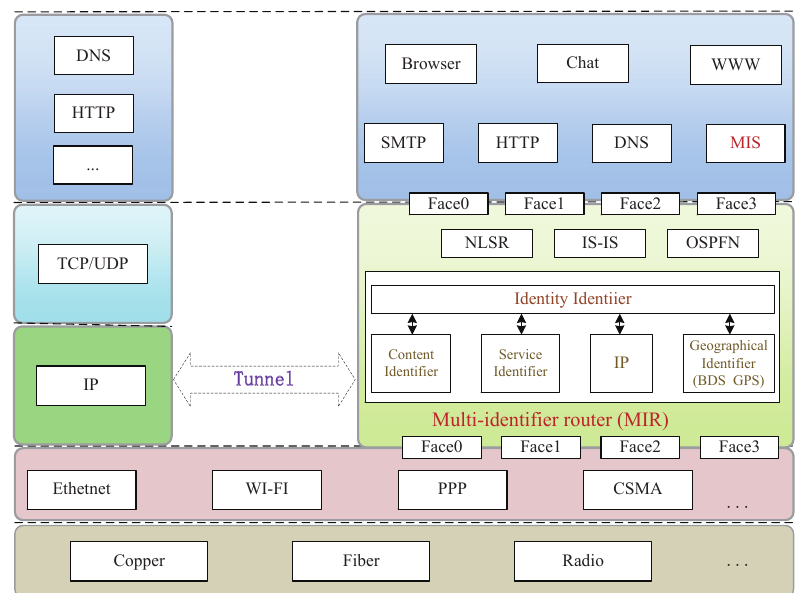
Figure 3. Multi-identifier network